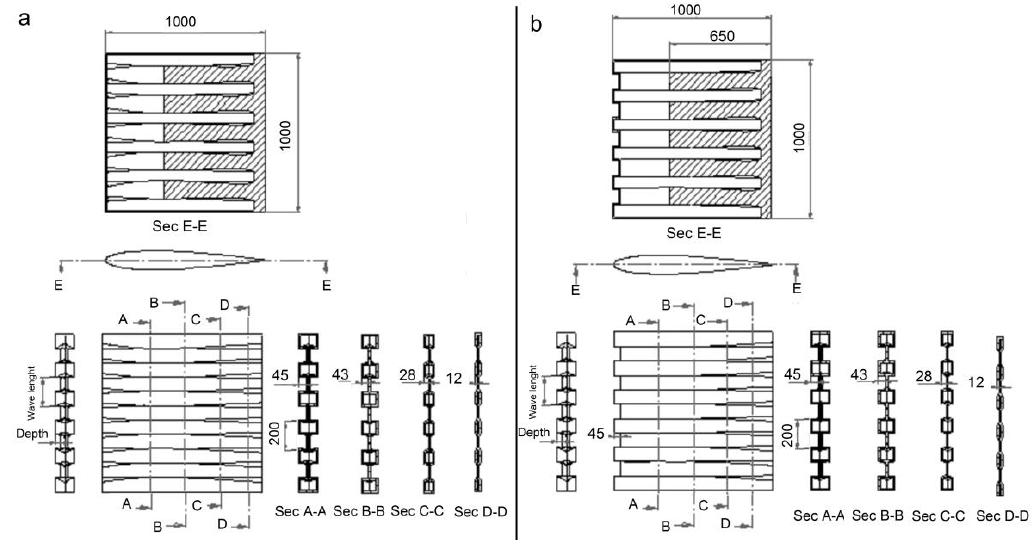
Figure 4. The main geometrical parameters, number of corrugations, the width and depth of corrugation along the span-wise are investigated in Figure 4. Figure 4a,b illustrates geometries of edges. The ridges of the corrugates are suggested to be have fillet radius not exceeding1 mm to avoid stress concentration. The depth to chord and the wavelength or pitch distance to chord ratios are 0.025, 0.2 respectively.